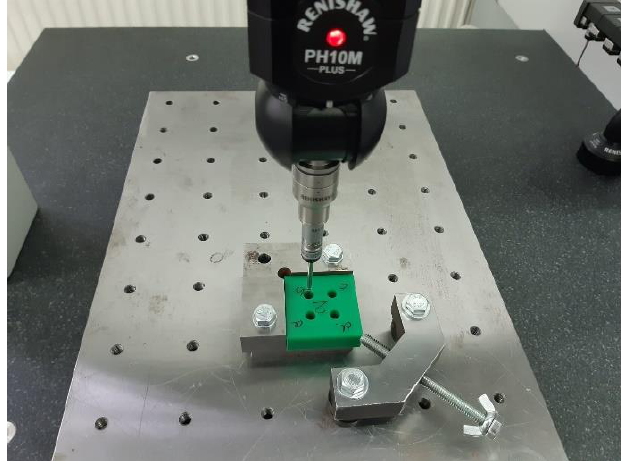
Figure 3. Four-hole specimen, specimen holder, and RENISHAW PH10M measuring head.